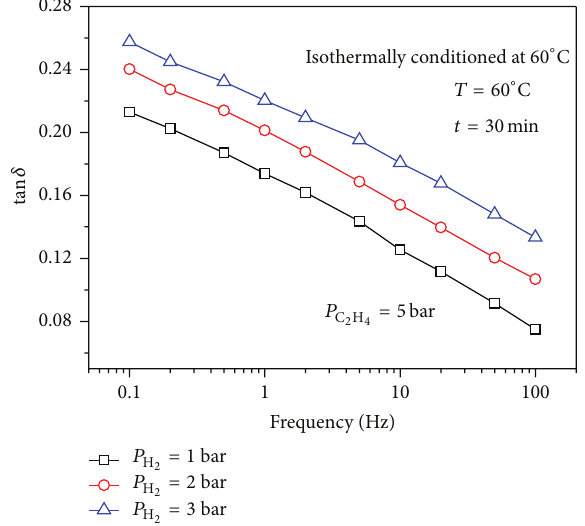
= 5 bar, Figure 4: tan 𝛿 of copolymers synthesized at 𝑃 C 2 H 4 𝑇 = 60 ∘ C, and 𝑡 = 30min (samples 1, 2, and 3). polymerization polymerization